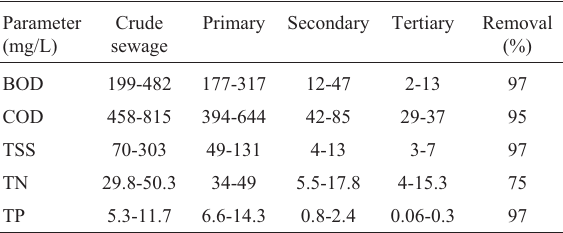
Table 1 - Physicochemical analyses and characterization of settled sewage samples: Profile of wastewater treatment plant during the study sampling.